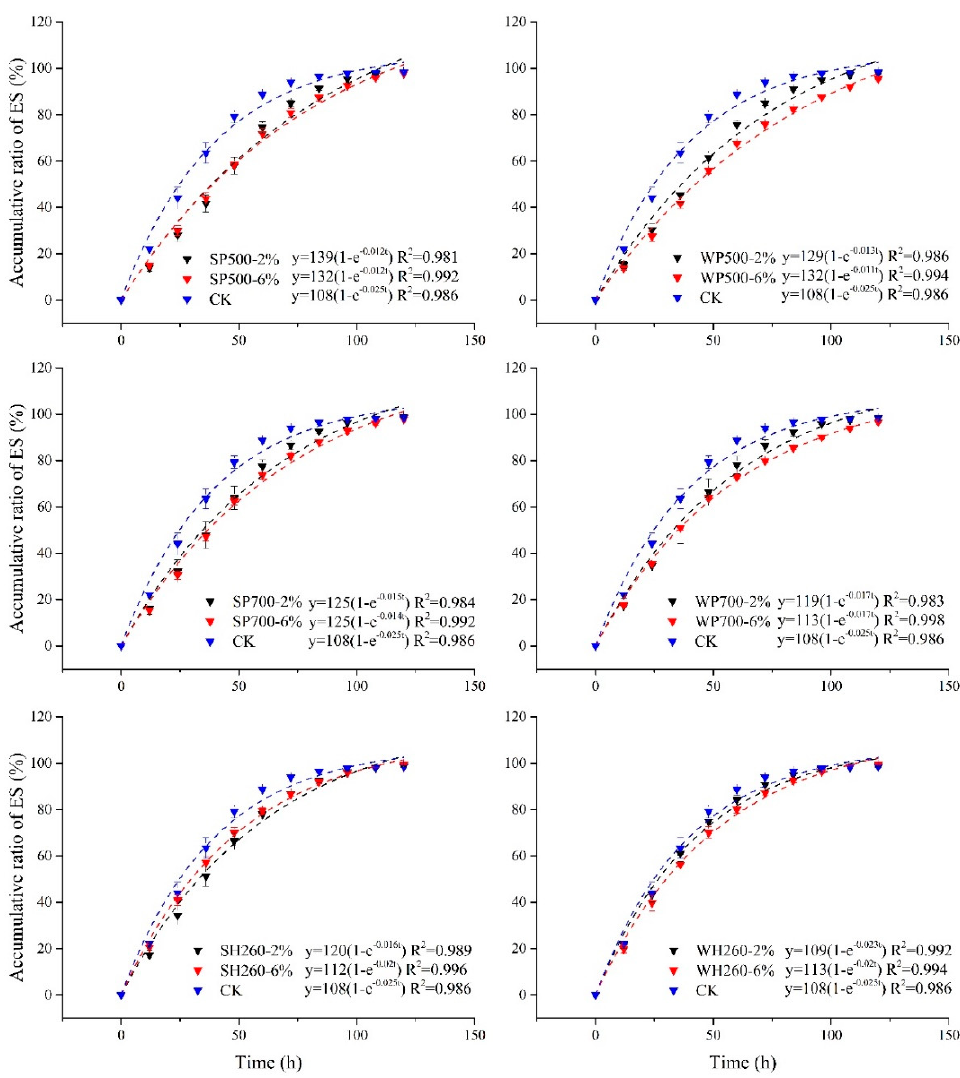
Figure 1. Accumulative soil evaporation and its first-order kinetics equation fitting under pyrochar and hydrochar application. Error bars represent standard deviations. Table 2. Parameters of the fitting equation of soil evaporation curves under pyrochar and hydrochar application.